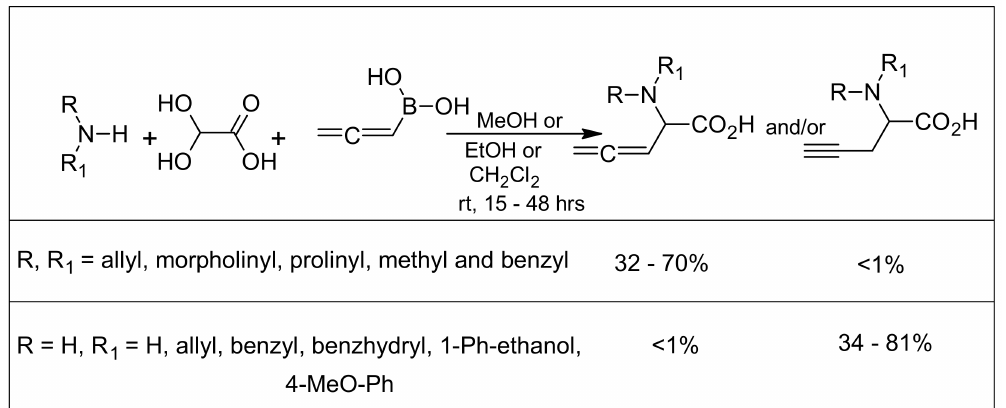
Scheme 21. Synthesis of α -propargyl and/or α -allenyl α -amino acids.